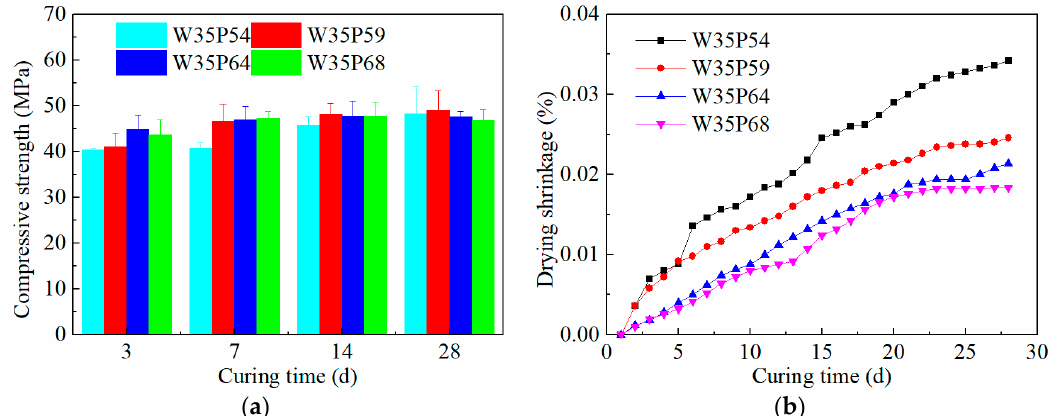
Figure 7. Effect of sand ratio on ( a ) compressive strength of AASC specimens; ( b ) drying shrinkage of AASC specimens.